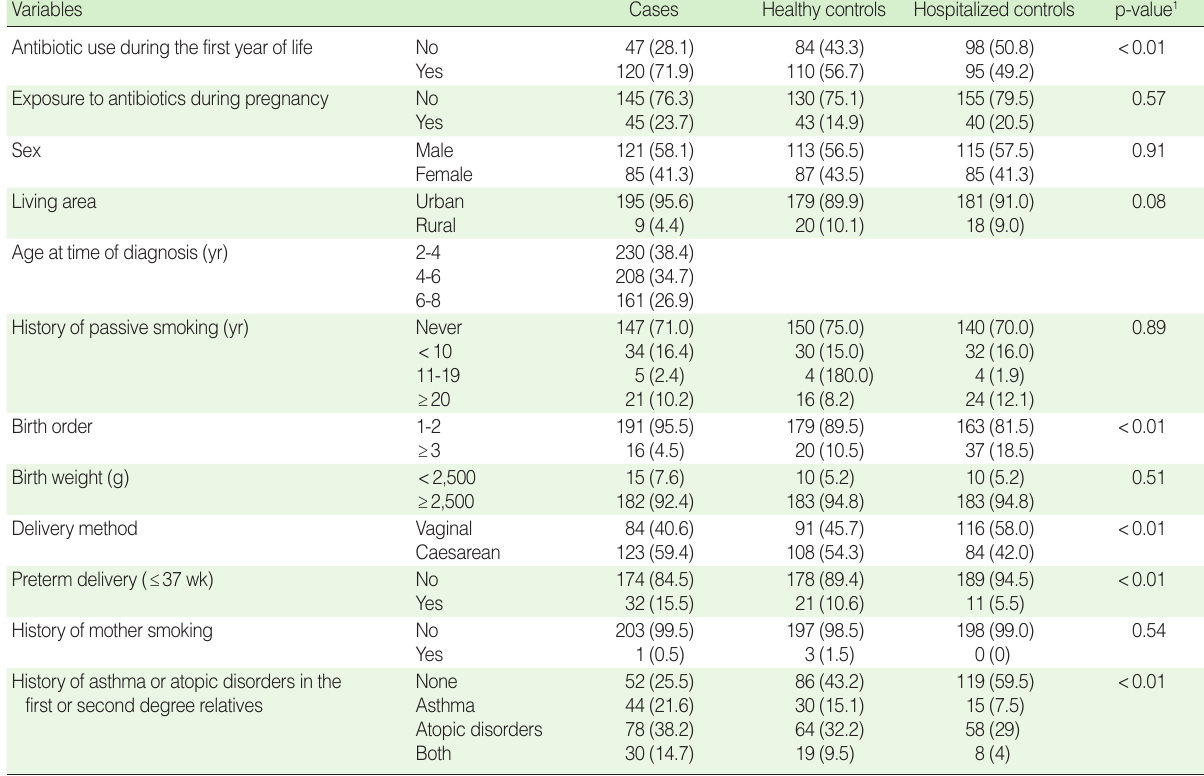
Table 1. Distribution of demographic and other features in the study population